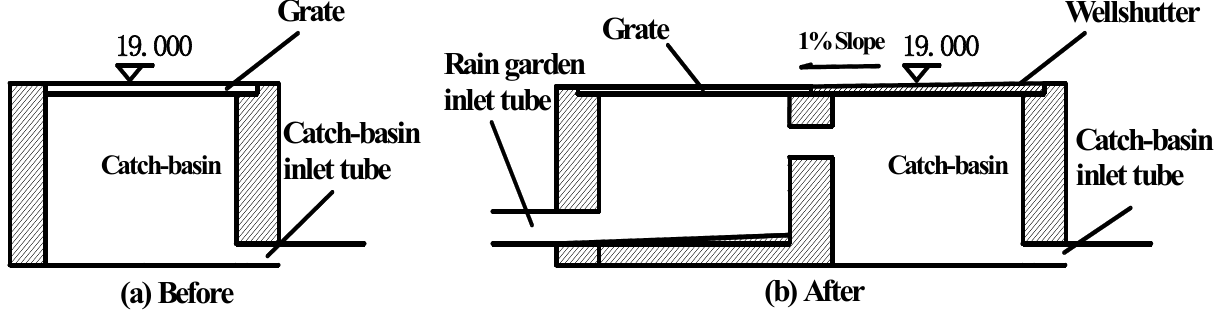
Figure 4. Before and after the inlet